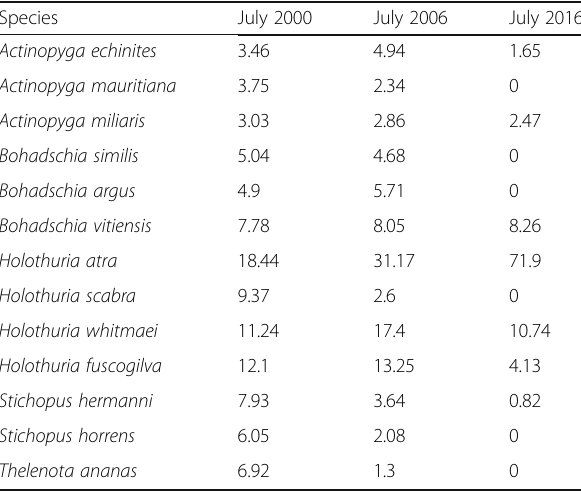
Table 4 The relative abundances (%) of different sea cucumber populations recorded during the period of study (2000 – 2016) at Abou Ghosoun area